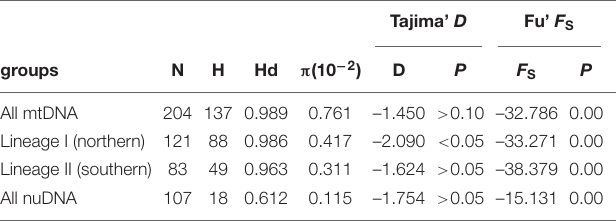
TABLE 3 | Neutrality test statistics (Tajima’ D and Fu’ F S ) for the all mitochondrial samples, two mitochondrial lineages, and all nuclear samples of Tridentiger bifasciatus populations.